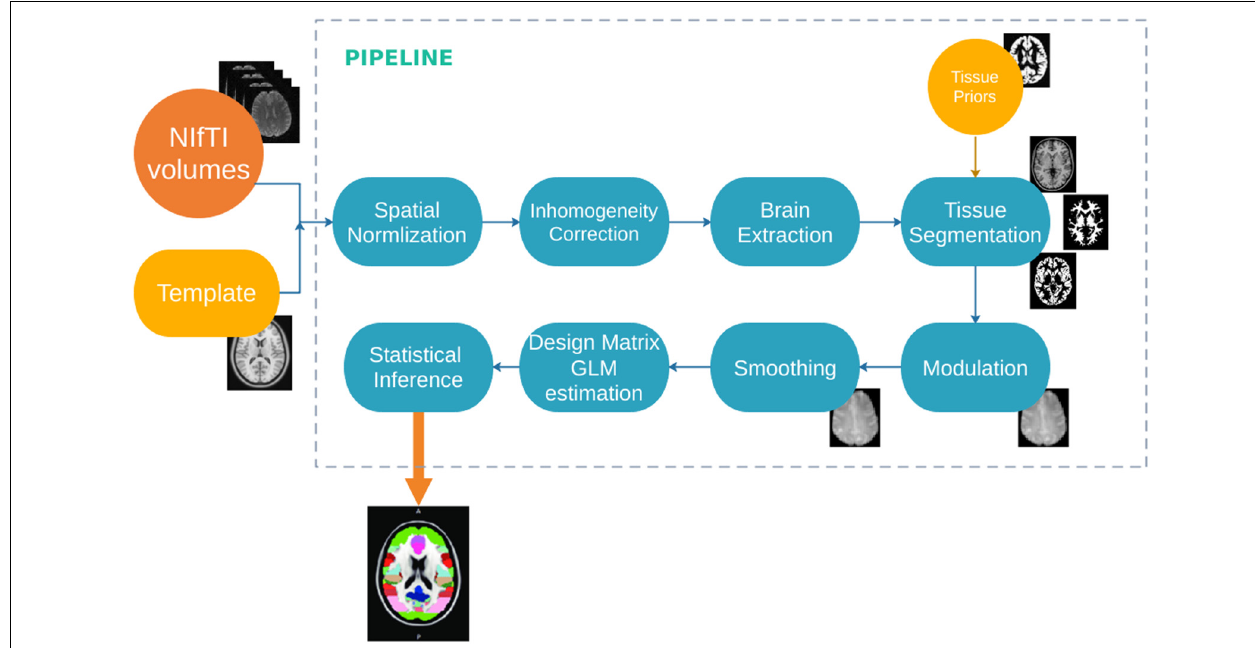
FIGURE 3 | Diagram of the image processing